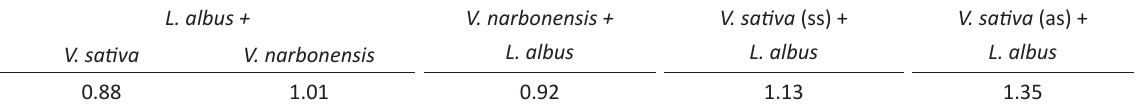
Table 5. Anatomical Equivalent Ratio (AER) values of intercropped legume species, based on volume densities of lignified